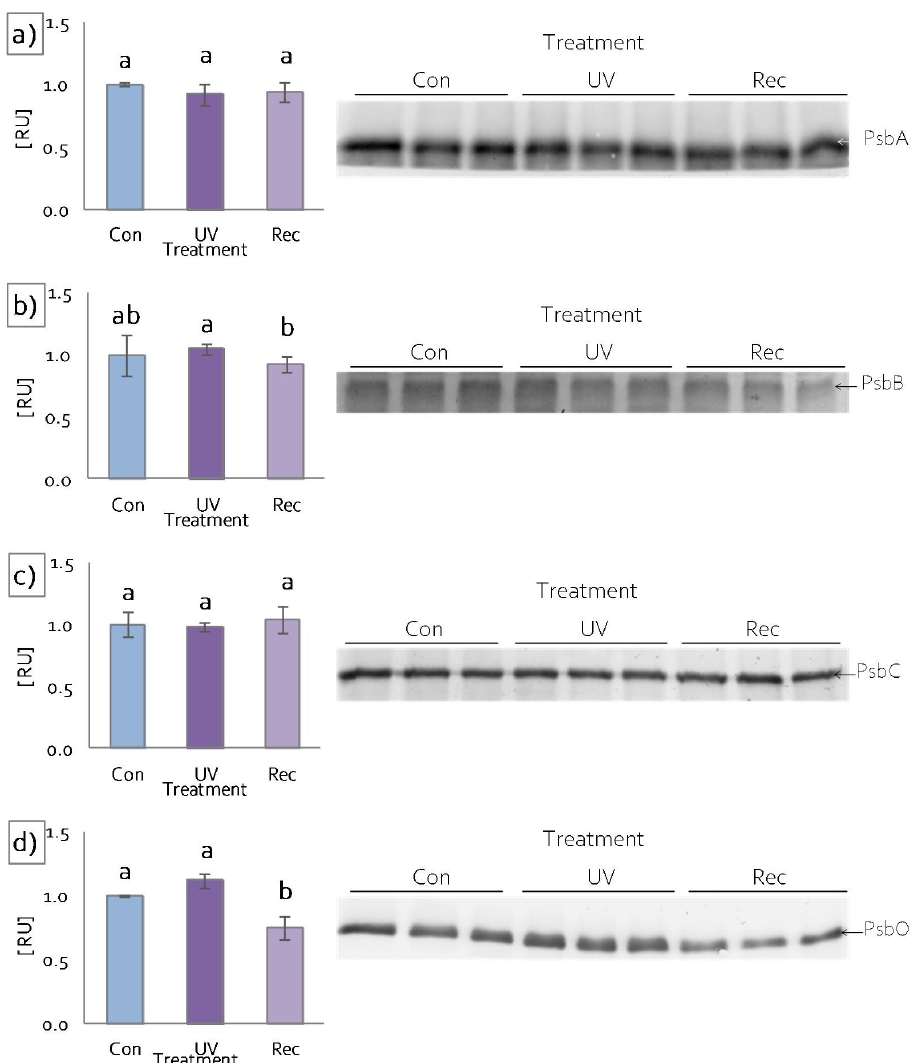
Figure 4. Response of D. muscipula photosynthetic apparatus to UV-A treatment. Content of ( a ) D1 protein of PSII (PsbA), ( b ) CP47 protein of PSII (PsbB), ( c ) CP43 protein of PSII (PsbC) and ( d ) oxygen-evolving enhancer protein 1 (PsbO); content of proteins expressed as relative units (RU); Con—control plants; UV—UV plants; Rec—recovery plants; different letters—statistically significant differences at p ≤ 0.05; n = 3.